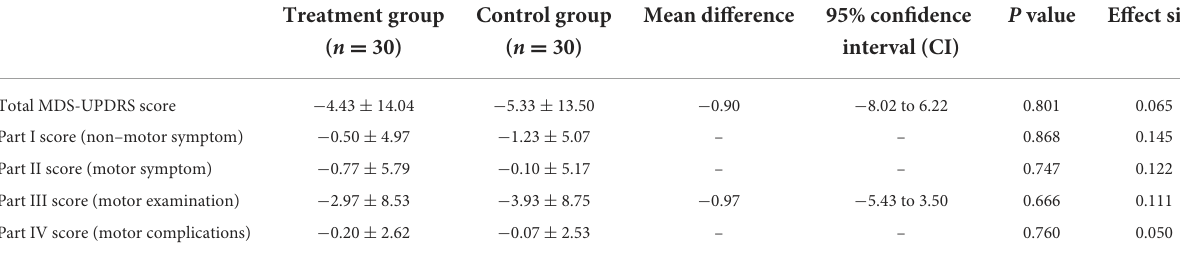
TABLE 5 The difference in MDS-UPDRS scores between groups from baseline to week 7.